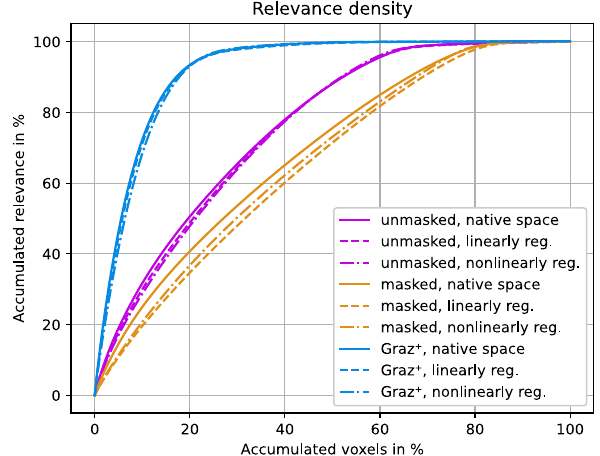
Figure 6. The relevance density describes the contribution of individual voxels to the classification decision. Removal of scalp tissue voxels (orange) yields higher relevance density compared to unmasked T1 images (purple). The Graz + -models (blue) identify sparser but substantially more relevant voxels, which improves the classification